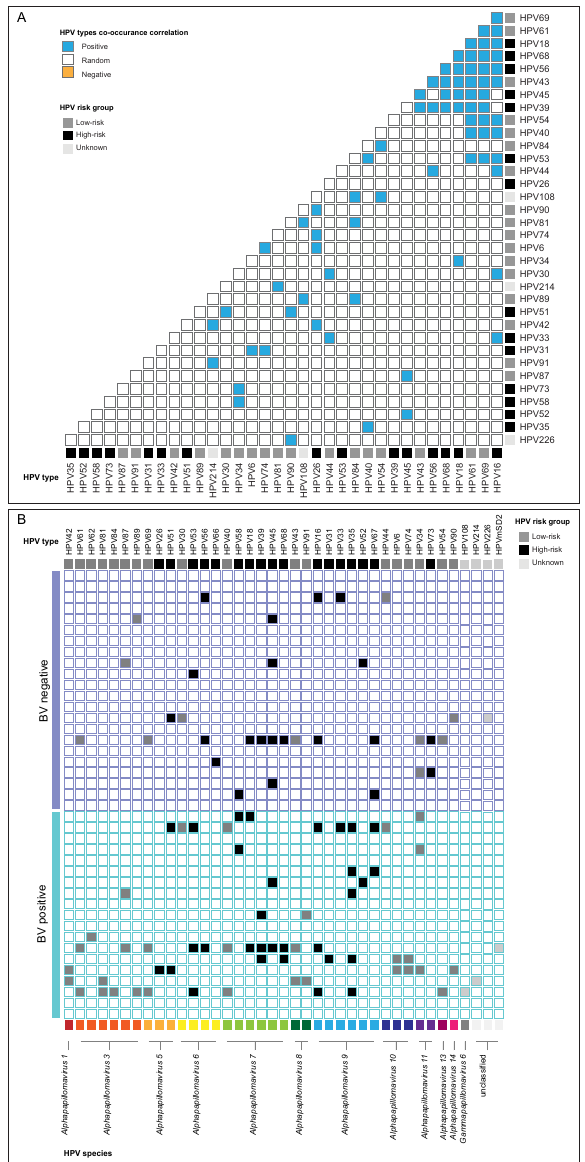
Figure 3. Occurrence of HPV genotypes. ( A ) Heat map showing the positive HPV genotype associ ‐ ations determined by a probabilistic co ‐ occurrence model [36]. Genotype names are positioned to indicate the columns and rows that represent their pairwise relationships with other species. Blue indicates that the co ‐ occurrence of HPV genotypes is significantly large and greater than expected (statistically significant positive association). This analysis included the HPV genotypes identified in the viral metagenome and whole community sequencing projects. The plot only includes the 35 HPV genotypes that had significant associations with one or more other HPV genotypes. ( B ) The occurrence of the 39 HPV genotypes identified in the 33 participants collected when women had BV (light blue, n = 19) and when BV was absent (dark blue, n = 22) is shown in a cross ‐ sectional com ‐ parison. HPV genotypes are annotated by risk classification and species. This analysis includes sam ‐ ples from the 33 women in the viral metagenome sequencing project.